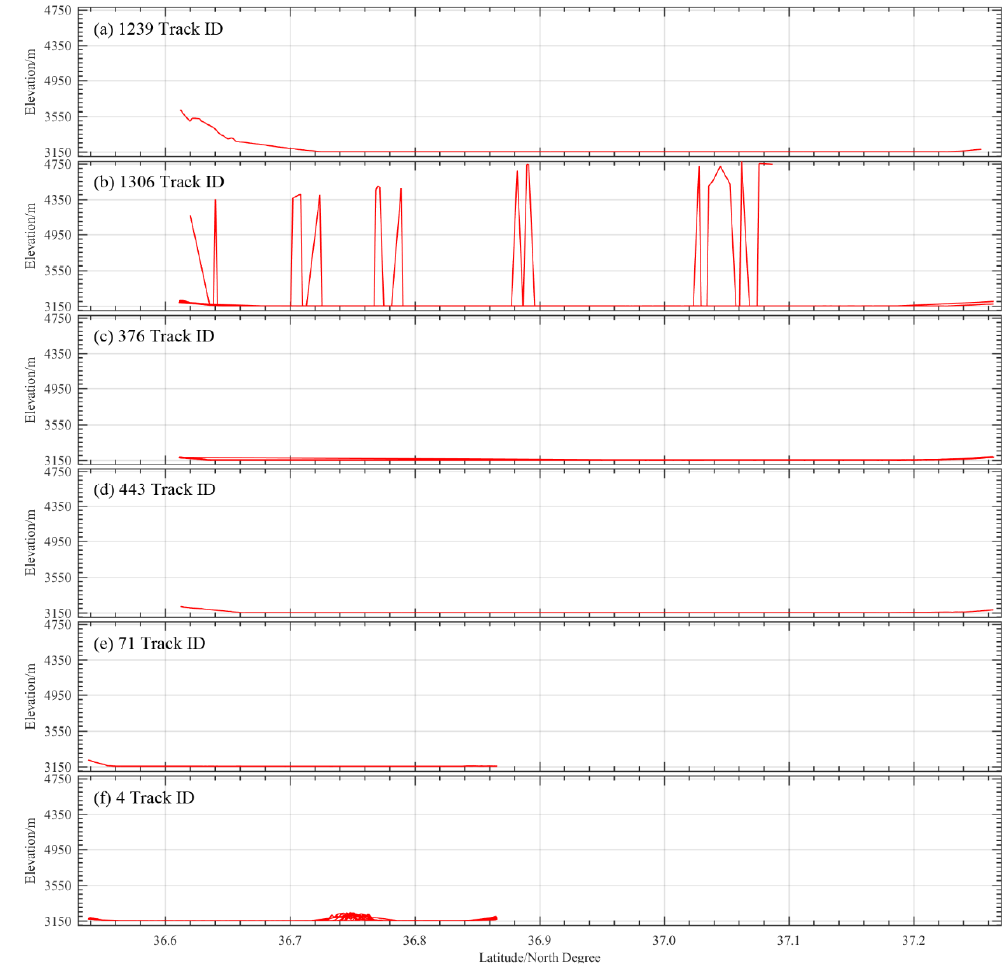
Figure 3. The elevation variation along the latitude in each track of ICESat.